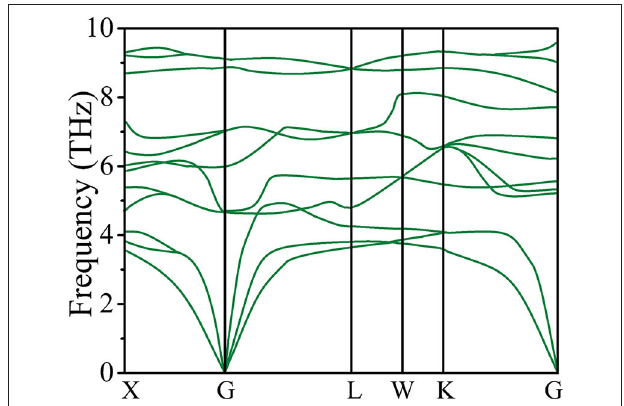
FIGURE 1 | Phonon dispersion curves of the CoCrScSn compound at equilibrium lattice